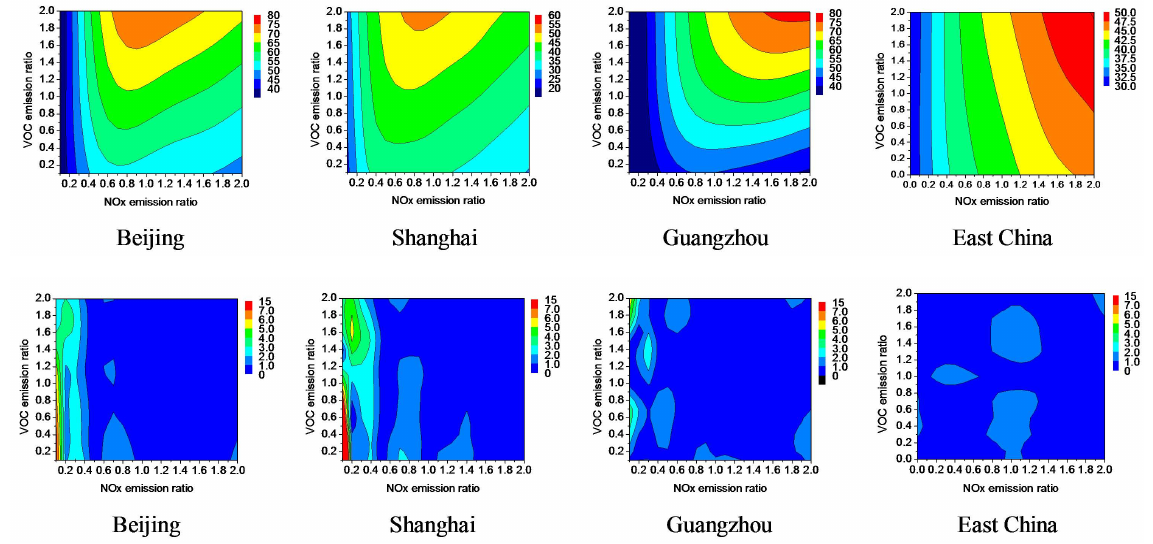
Fig. 5. 2-D isopleths validation of HSS6-200, (a) 2-D Isopleths of Ozone from HSS6-200 (monthly mean of daily 1-h maxima, July 2005,